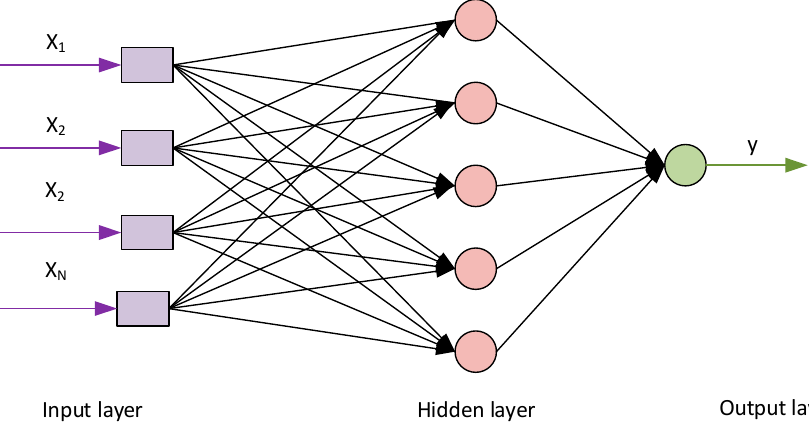
Figure 9. Model of the artificial neural network [13,43].